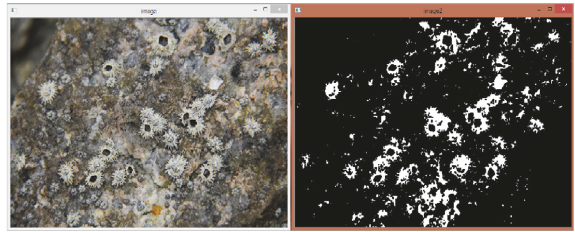
Figure 12: Acorn barnacle percent fouling over the total